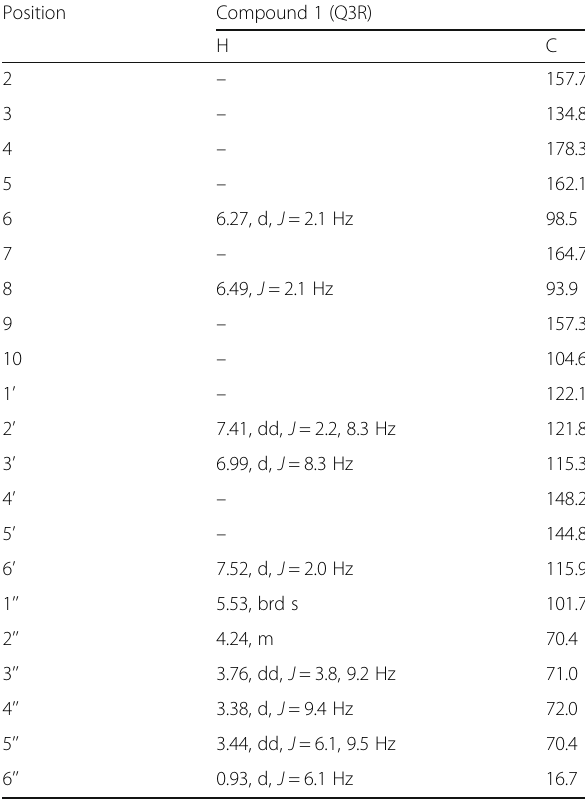
Table 2 1 H NMR and 13 C NMR data of compound 1 (Q3R) (in DMSO- d 6 ) Position Compound 1